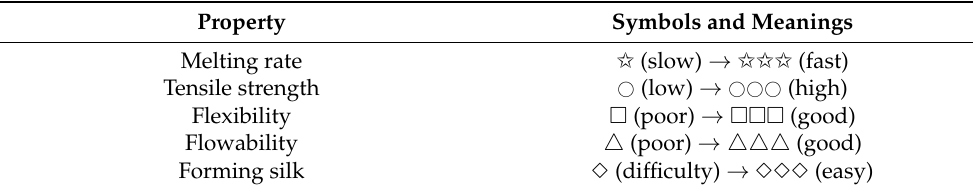
Table 1. Concerned properties, symbols and meanings of the molten mass and YAG ceramic